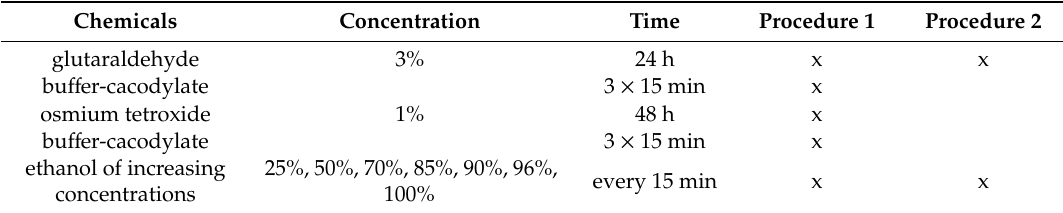
Table 1. Working procedures for product processing.